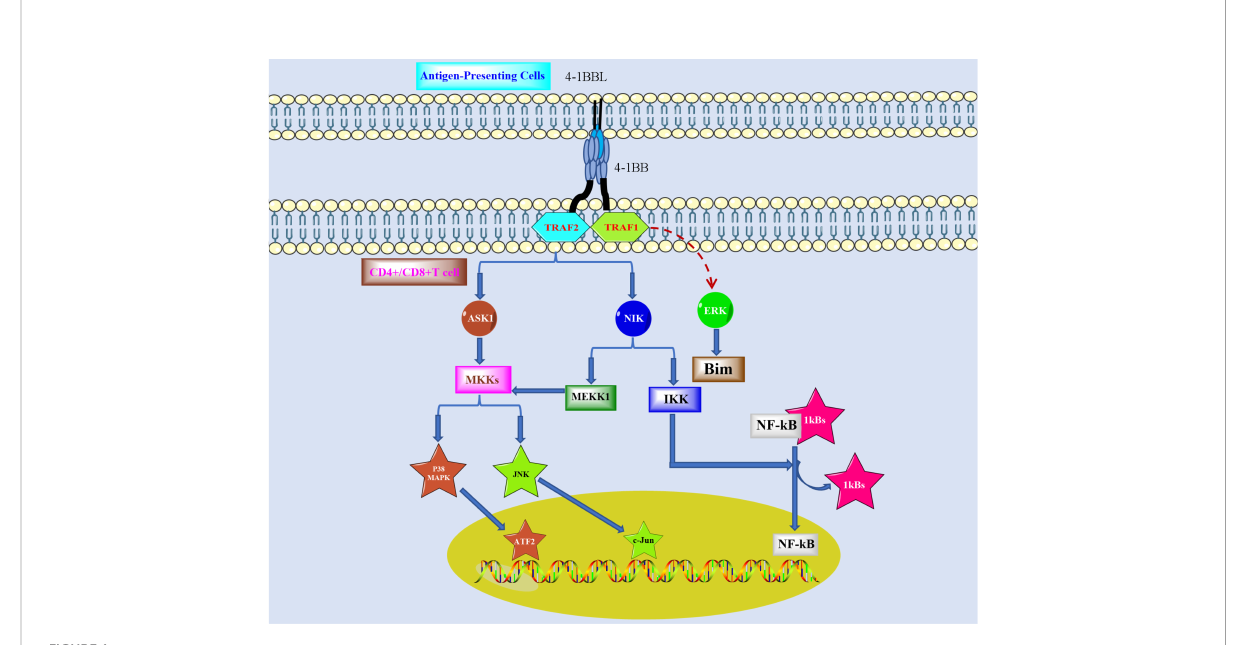
FIGURE 1 Role of 4-1BB in the tumor